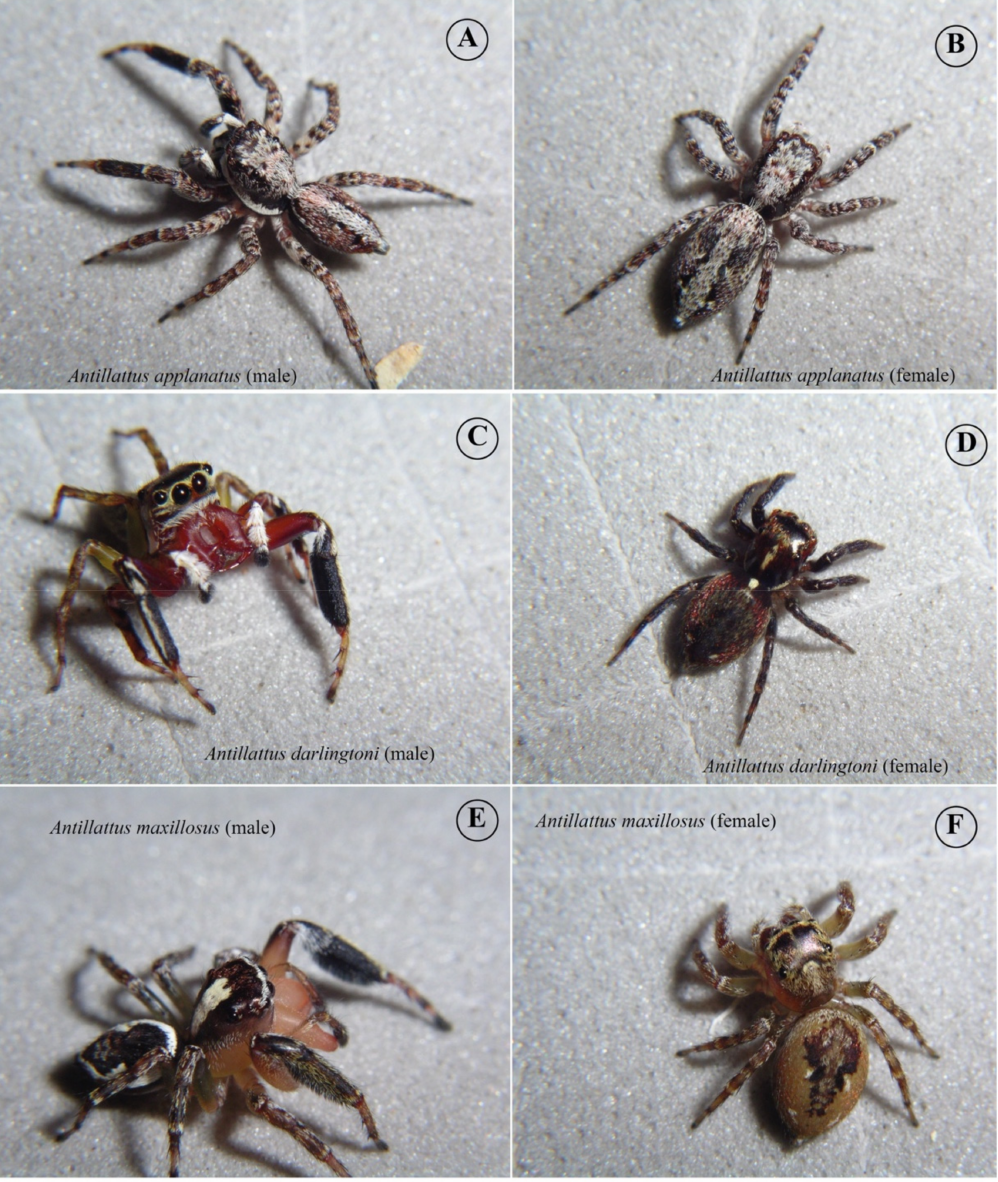
Figure 3. A – F darlingtoni group. ( A , B ) Antillattus applanatus , male and female habitus. ( C , D ) Antillat- tus darlingtoni , male and female habitus. ( E , F ) Antillattus maxillosus , male and female habitus. Images by Wayne Maddison, released under a Creative Commons Attribution (CC–BY) 3.0